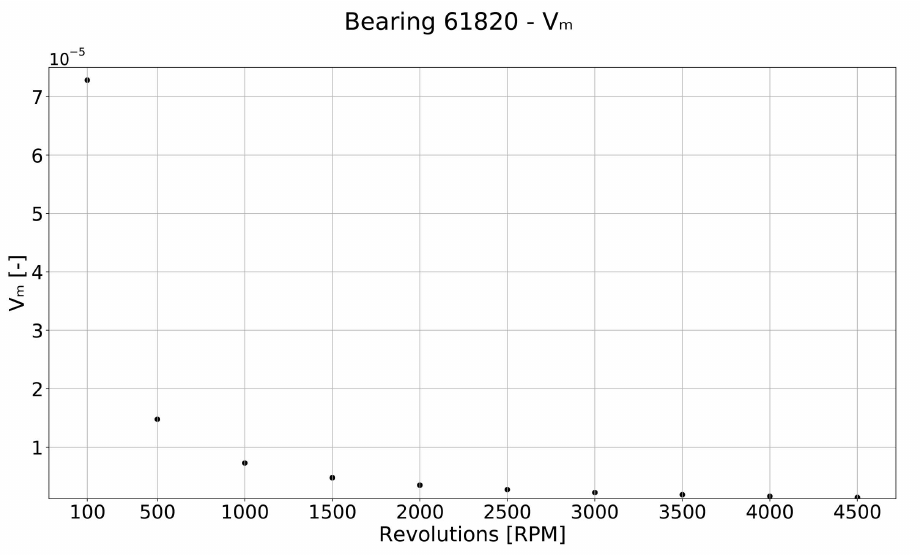
Figure 10. Bearing 61820 water— V m drag loss factor—SKF